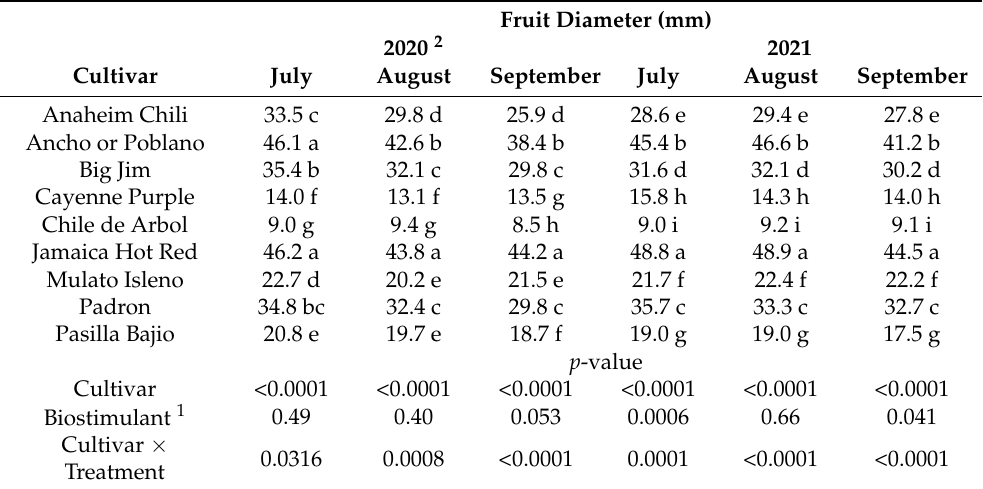
Table 7. Fruit diameter of nine heirloom chili pepper cultivars grown in a container production system in Starkville, Mississippi, during two growing